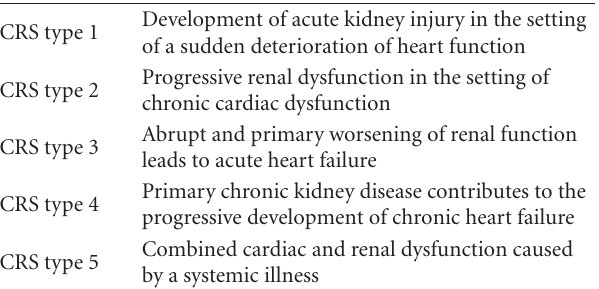
Table 1: Cardiorenal syndrome: classification.